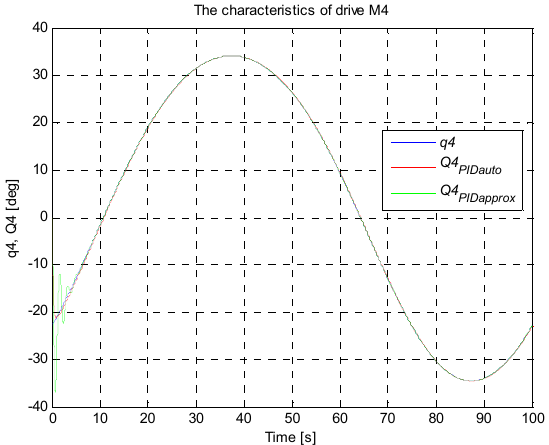
Figure 21. The courses of set and controlled configurational variables for the drive of the fourth arm. Table 4. ISE indicators for simulation studies of the control system. PID Controller Settings